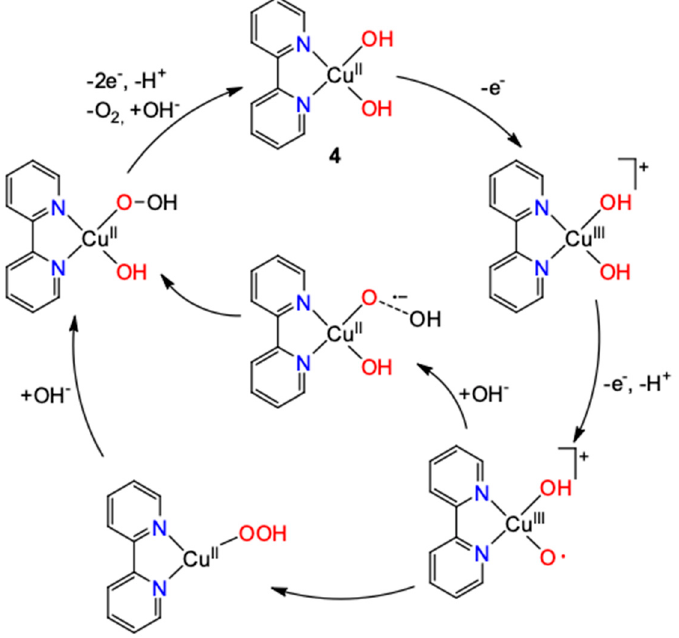
Figure 6. Mechanistic scheme of the OER catalyzed by 4 [29].